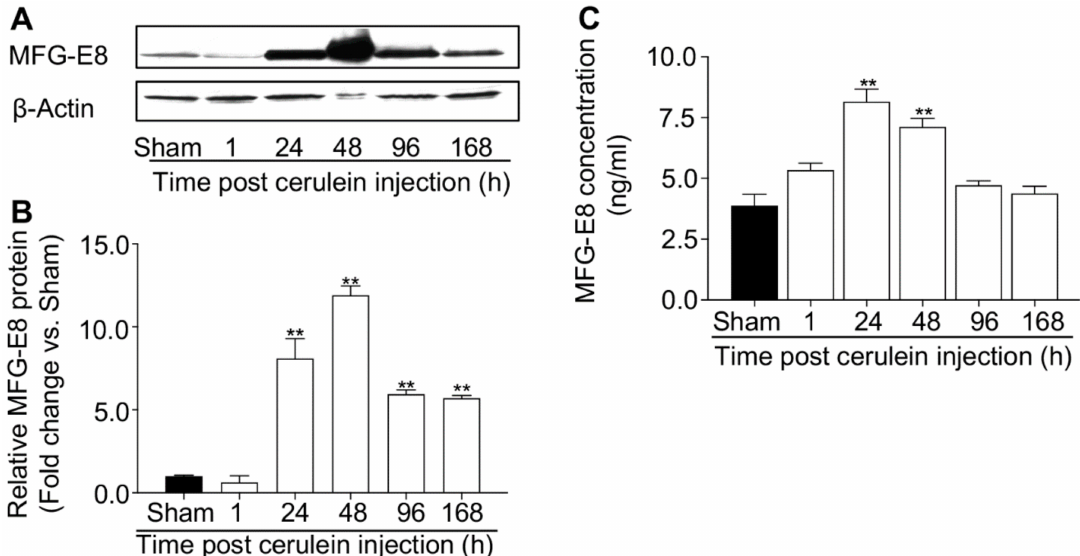
Figure 1. Cerulein-induced acute pancreatitis is associated with upregulation of MFG-E8. ( A , B ) Young adult C57BL/6J mice (male, 8–10 weeks old) were subjected to 10 hourly intraperitoneal (IP) injections of cerulein (50 µ g/kg) and euthanized at the timepoints indicated. Mice in the sham-group were treated with saline. Pancreatic tissue was collected and processed for MFG-E8 immunoblot analysis. Panel A shows a representative immunoblot and panel B shows densitometric analysis of the immunoblot data (normalized to β -Actin, n = 3 per time point). ** p < 0.01 versus sham. ( C ) Plasma samples were collected at the indicated timepoints and processed to quantify MFG-E8 levels by ELISA. n = 6 each time point. ** p < 0.01 versus sham controls.